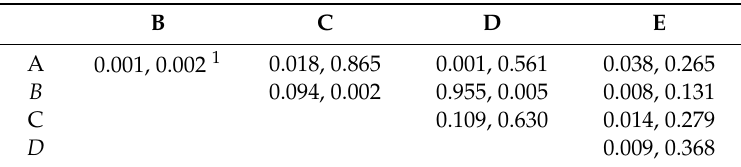
Table 3. t -test p values of gains among